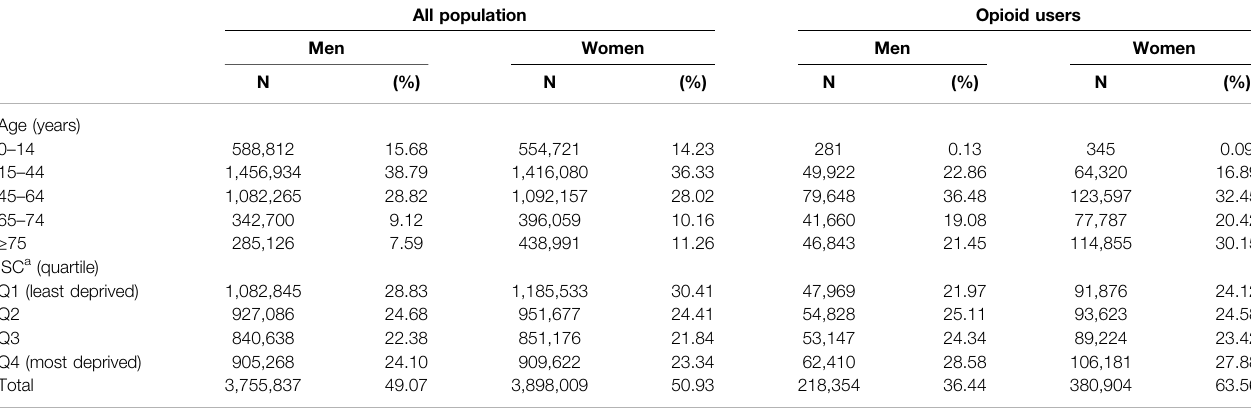
TABLE 1 | Descriptive characteristics of the population and opioid users of Catalonia, 2019.